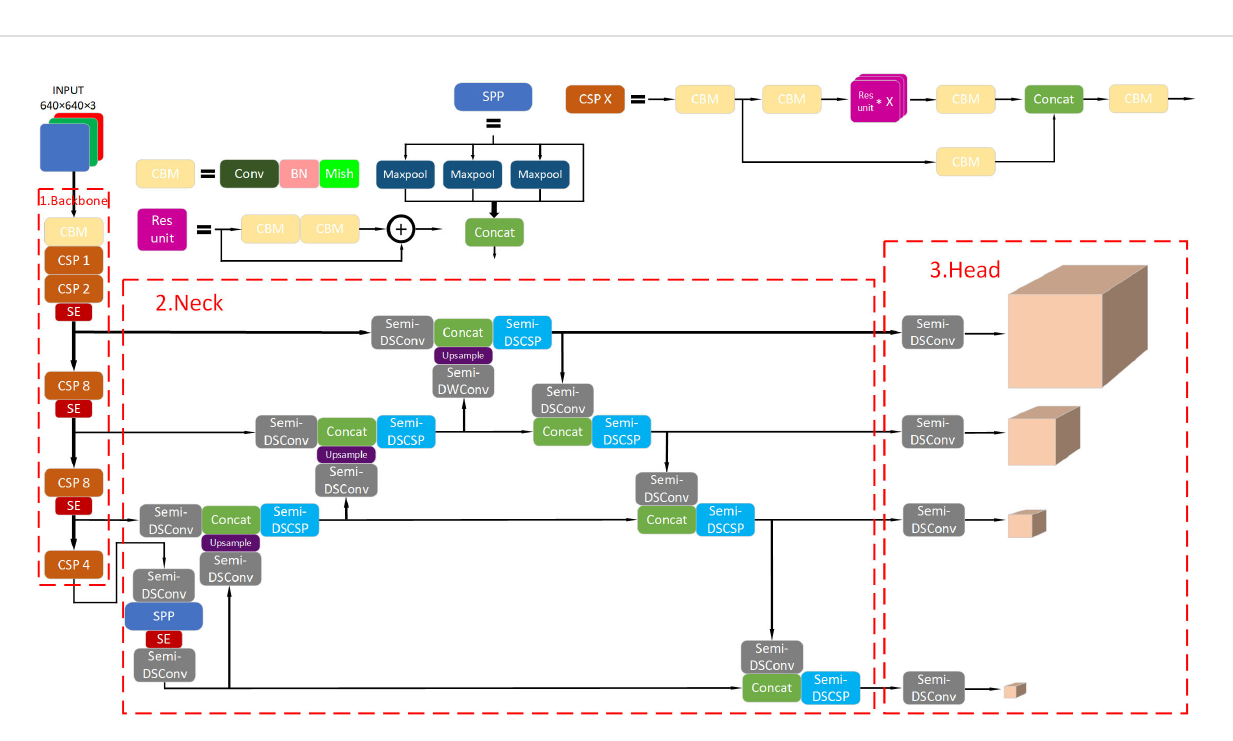
FIGURE 3 The improved YOLOv4 network